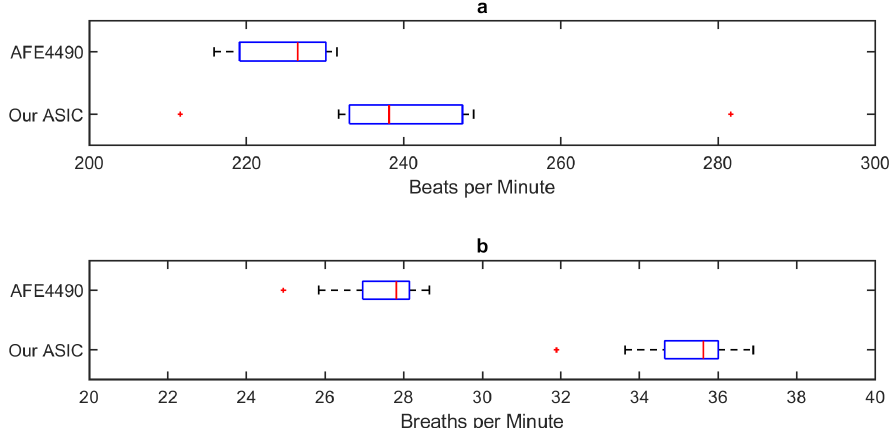
Figure 17. Whisker plot of the extracted ( a ) heart rate and ( b ) respiration rate values consecutively obtained using the presented ASIC and COTS AFE4490. The measured values were in the expected range as verified by alternative methods performed by veterinarians. The blue boxes, the red lines within the boxes, and the red markers outside denote the interquartile ranges, their medians, and the outliers (based on the 1.5 IQR rule)